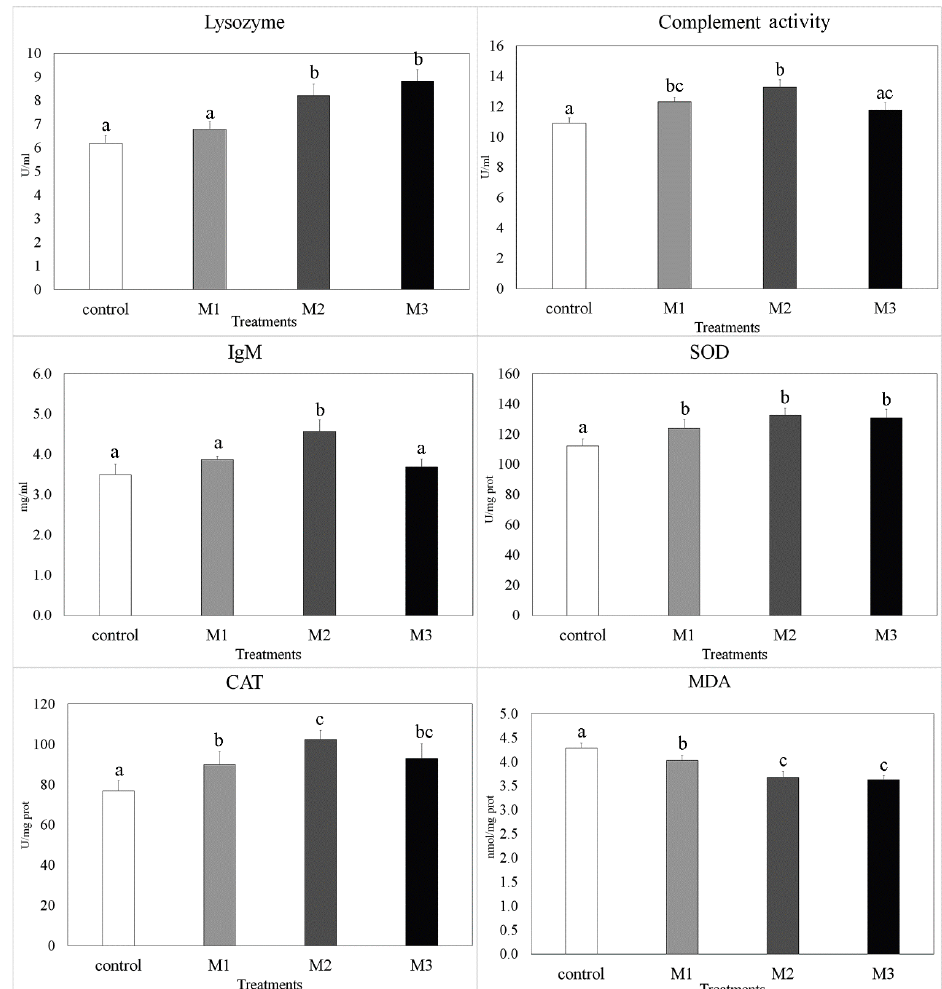
Figure 1. Serum immunological response (lysozyme, complement activity, total Ig), antioxidant enzymes activity (SOD— superoxide dismutase, CAT—catalase) and MDA (malondialdehyde) levels of zebrafish ( Danio rerio ) fed on four experimental diets: 0% (control), 0.5% (M1), 1% (M2) and 2% (M3) inclusion of the extract per kg diet for eight weeks. Different letters indicate significant differences between treatments ( p < 0.05). Data represent mean ± SE.